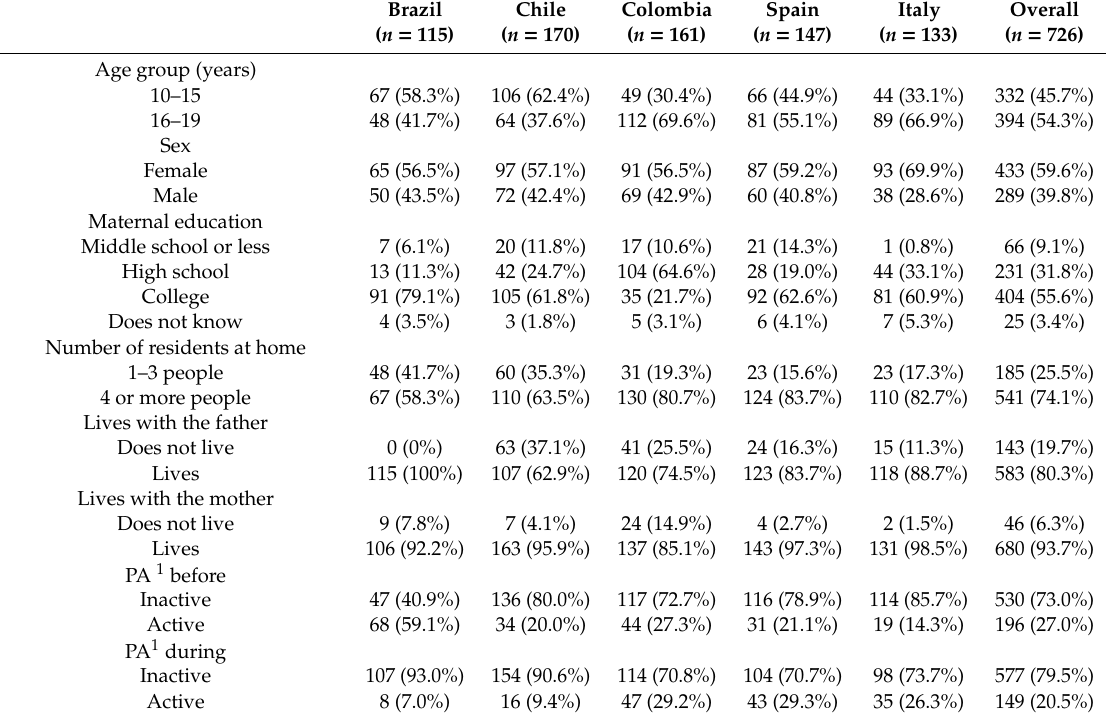
Table 1. General characteristics of the sample (by country and